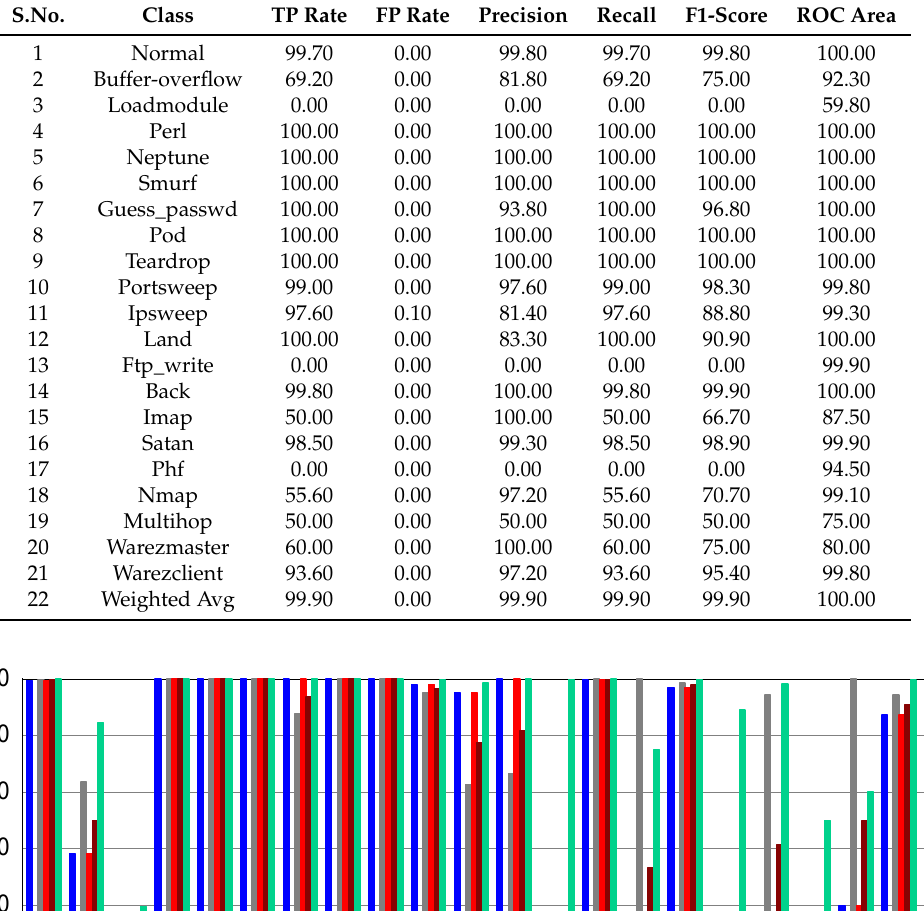
Table 24. Multiclass classification report for KDD99 using Bagging J48.